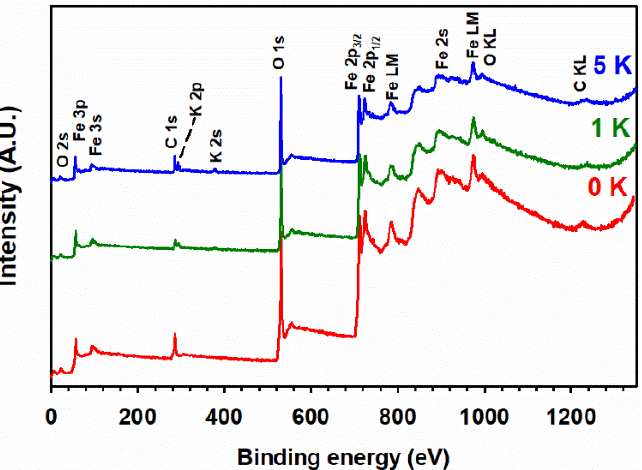
Figure 5. X-ray photoelectron (XPS) survey spectra for 100 Fe: x K materials with x = 0, 1, and 5, as indicated by the red, green, and blue traces, respectively. The peak assignment is based on the binding energy of photoelectron and Auger electron lines.